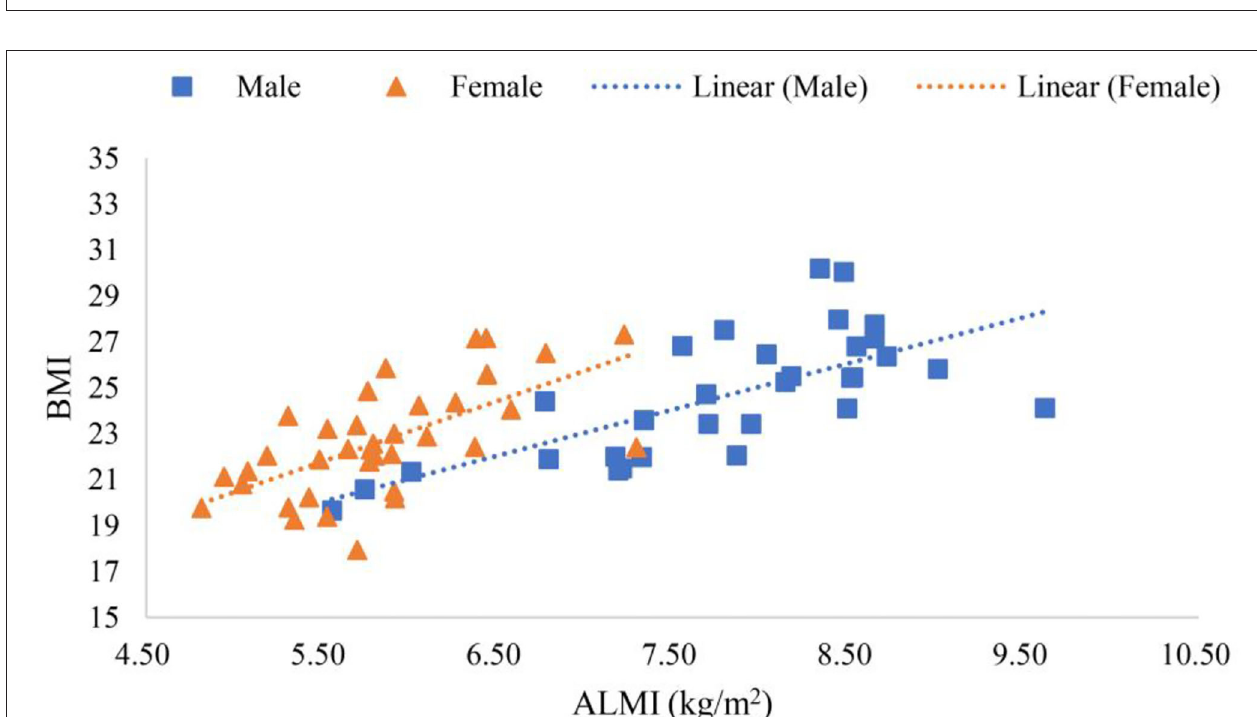
FIGURE 6 | Scatter plots of participants’ BMI and ALMI.